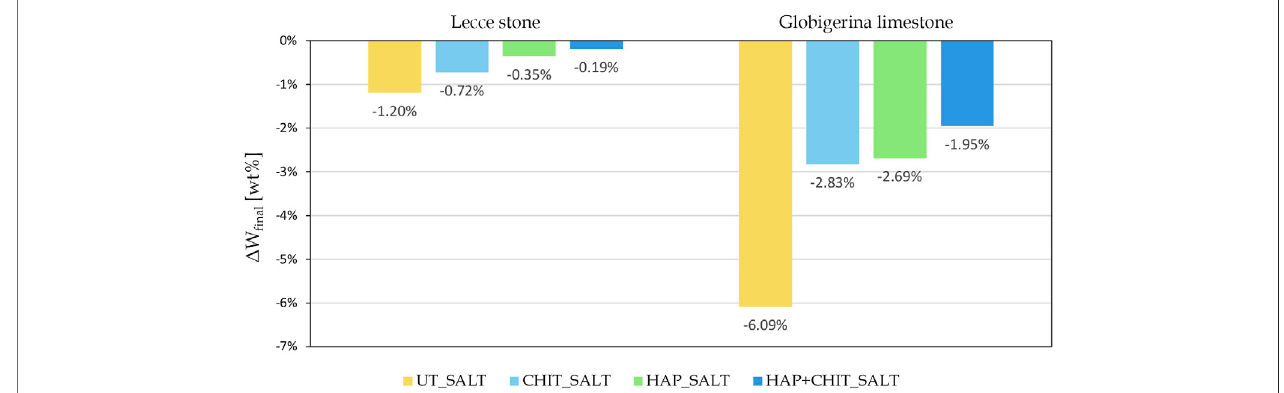
FIGURE 11 | Change in the fi nal dry weight of the prisms after the second absorption test, after brushing, compared to the initial weight for the samples.